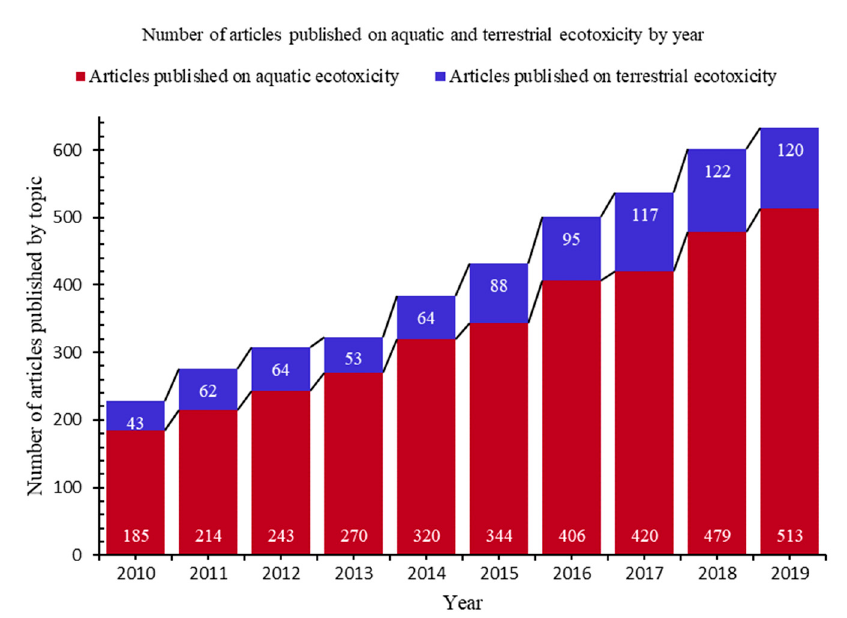
Figure 3. Bibliometric analysis of research on aquatic and terrestrial ecotoxicity in 2010–2019 from Web of Science Core Collection (Web of Science, Clarivate Analytics), the search strategy used to retrieve the data being: TS = (aquat* AND ecotox*) (containing both “aquat” and “ecotox” in the topic of the articles) and TS = (terrestr* AND